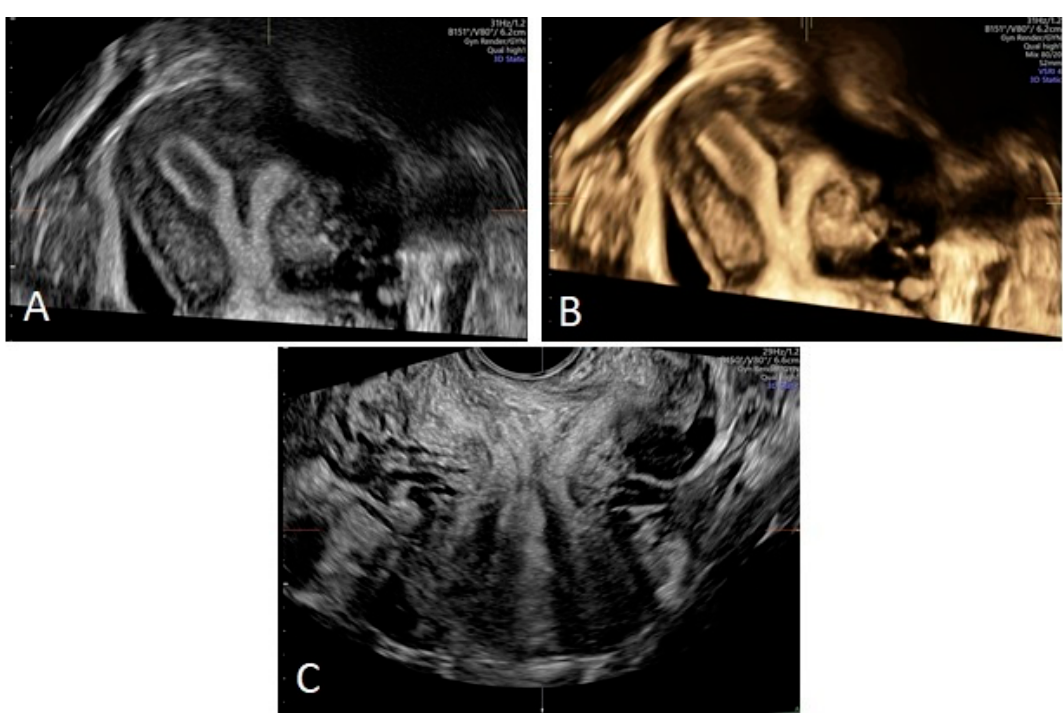
Figure 4. 3D ultrasound of complete septate uterus. ( A ) and ( B ) Two uterine bodies divided by a septum; ( C ) Two uterine cervices.